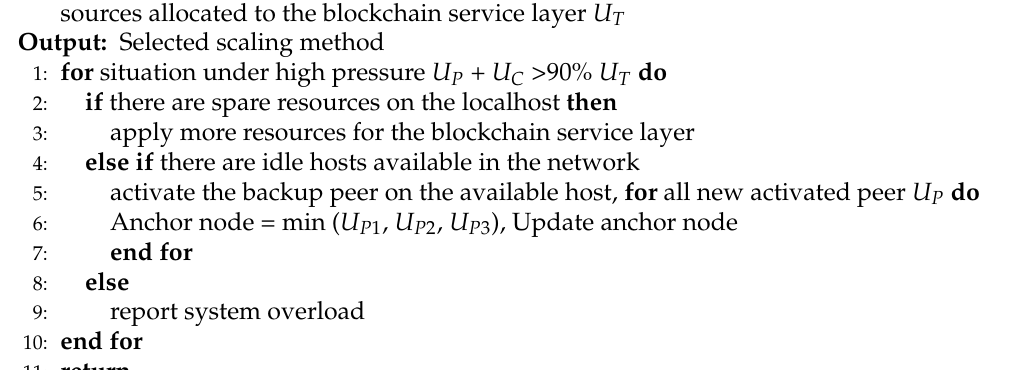
Algorithm 2 Scaling control algorithm.